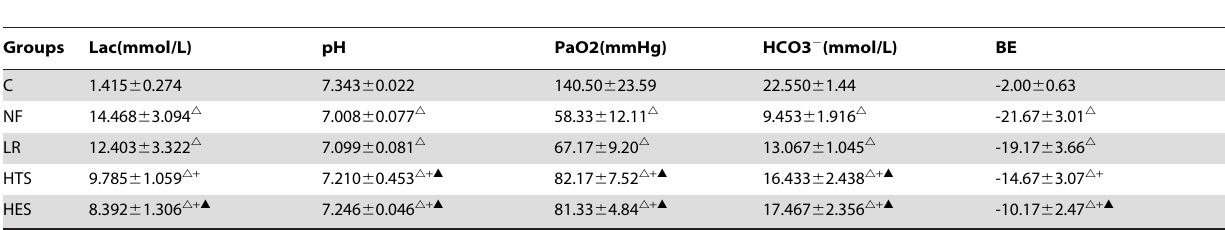
Table 2. The results of arterial blood gases at the end of the experiment (6 animals in each group).